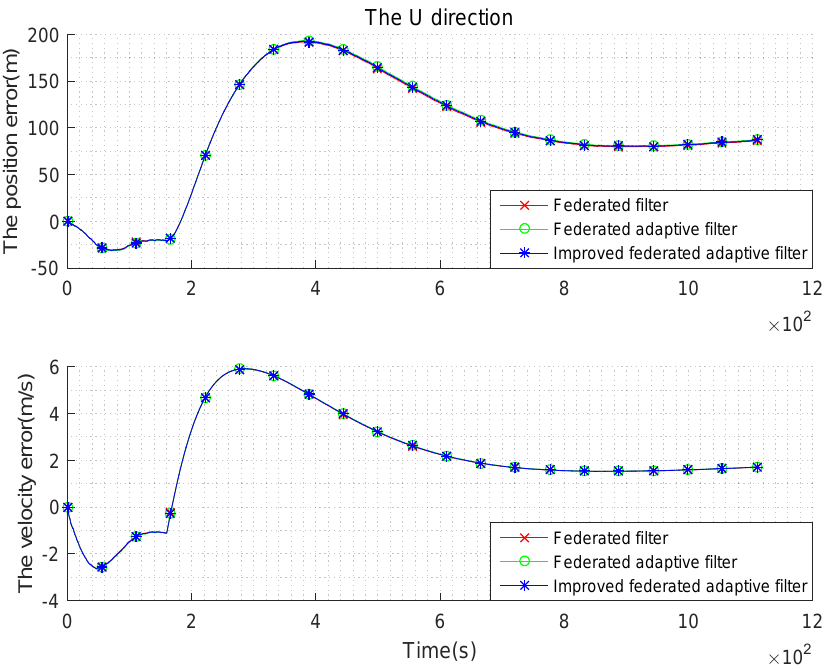
Figure 6. Comparison of the navigation error with Gaussian state noise and unbiased estimation in U direction.